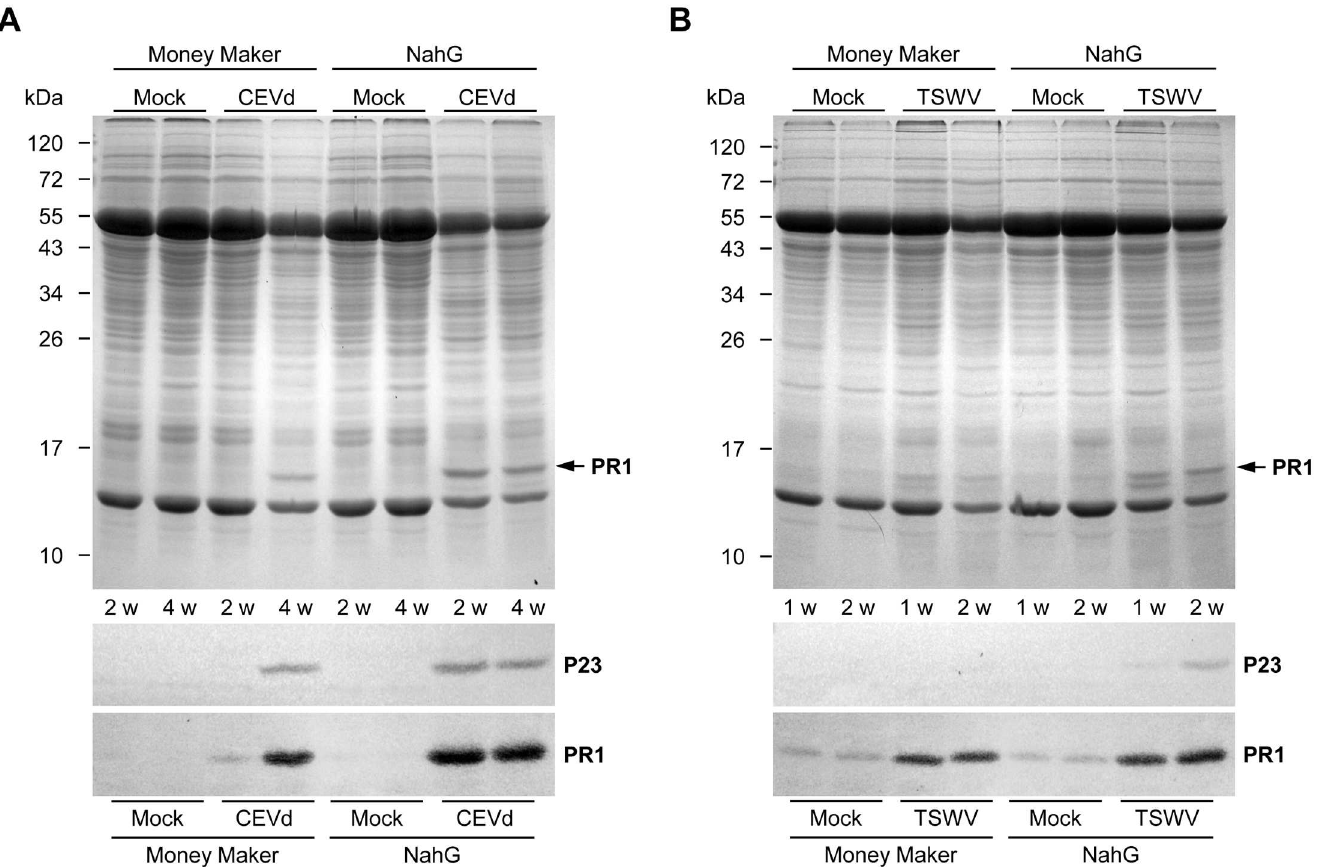
Fig 10. Accumulation of Pathogenesis-Related (PR) proteins in Money Maker and NahG tomato plants upon viroid and virus infection. Plants were inoculatedwith either Citrus Exocortis Viroid (CEVd, A) or Tomato Spotted Wilt Virus (TSWV, B) , and samples were collectedat the indicatedtimes (weeks post-inoculation, wpi) for both infected and mock-inoculated plants. Crude extracts were separatedby SDS-PAGE and the presence of PR1 and P23 was detected by immunoblot. Upper panelscorrespondto CoomassieBlue stainedSDS-PAGE gels (14% acrylamide). Lower panels show the immunostaining of P23 (23 kDa) and PR1 (14